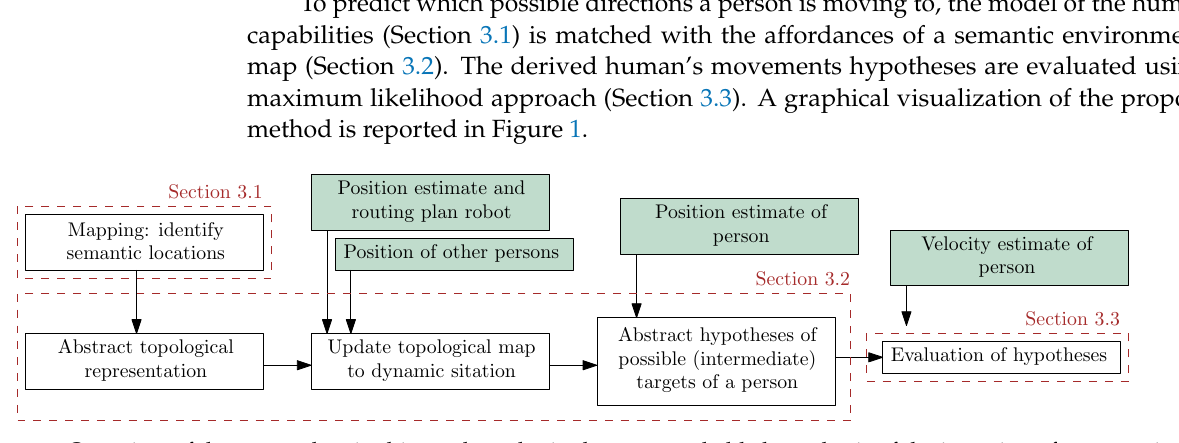
Figure 1. Overview of the steps taken in this work to obtain the most probable hypothesis of the intention of a person in an indoor environment. The green blocks indicate (filtered) observations or information required from other components, which are assumed to be available in the system such as a human detection